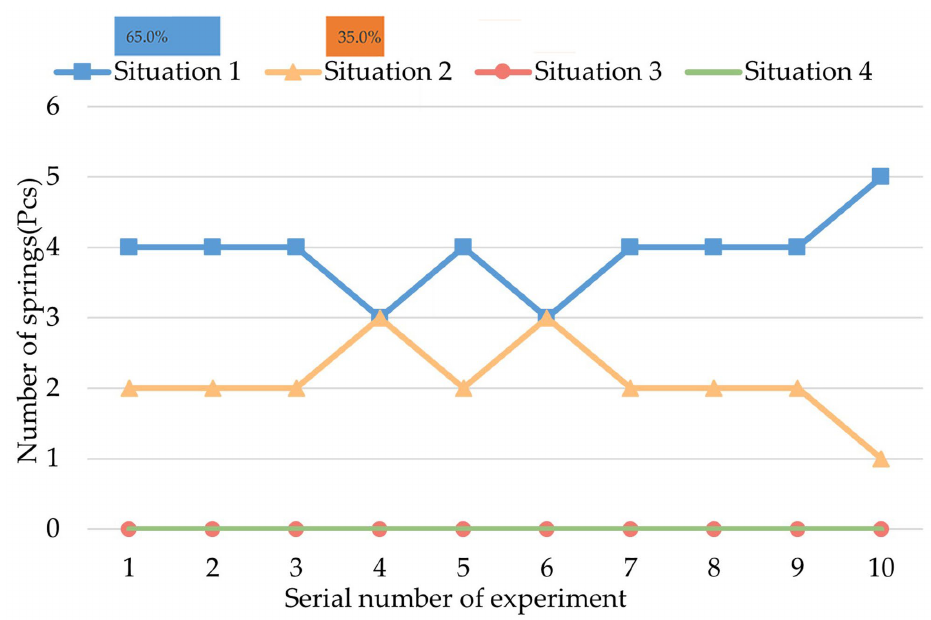
Figure 10. Result of group I of experiments.